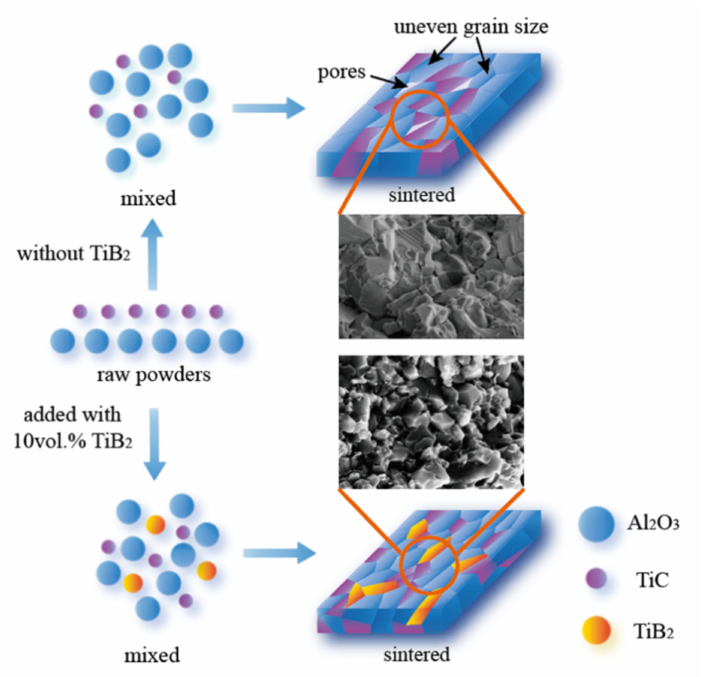
Figure 7. Sintering comparison chart of Al 2 O 3 /TiC and Al 2 O 3 /TiC/10 vol.% TiB 2 ceramic tool